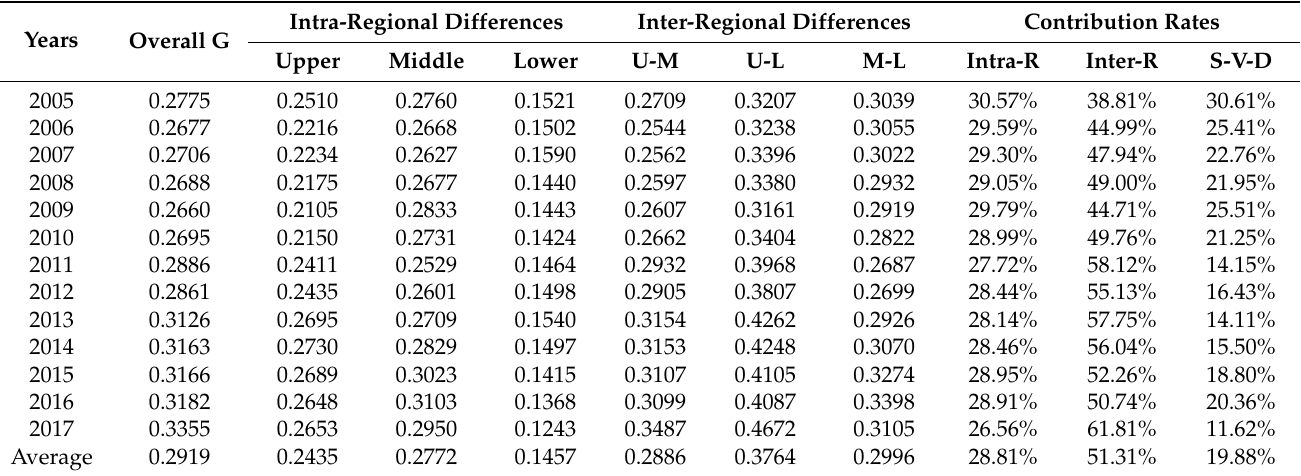
Table 4. All abbreviations appearing in this paper are shown in Table 5. Table 4. Regional differences in carbon emission intensity and their contribution in the YRB.